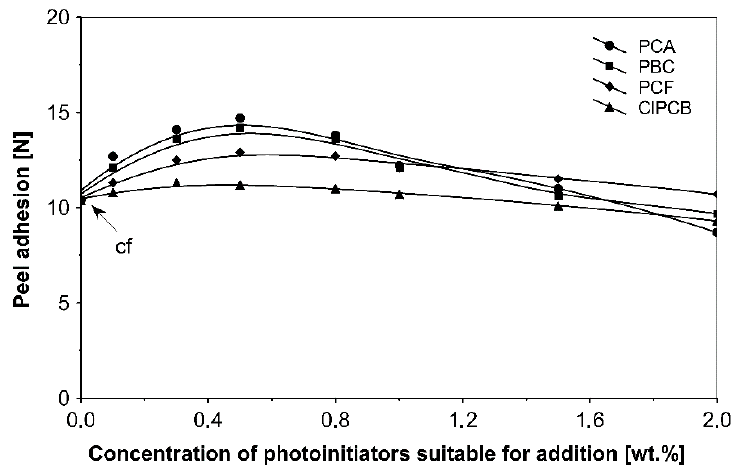
Figure 3. Peel adhesion of acrylic PSAs containing additionable photoinitiators after UV cross-linking .